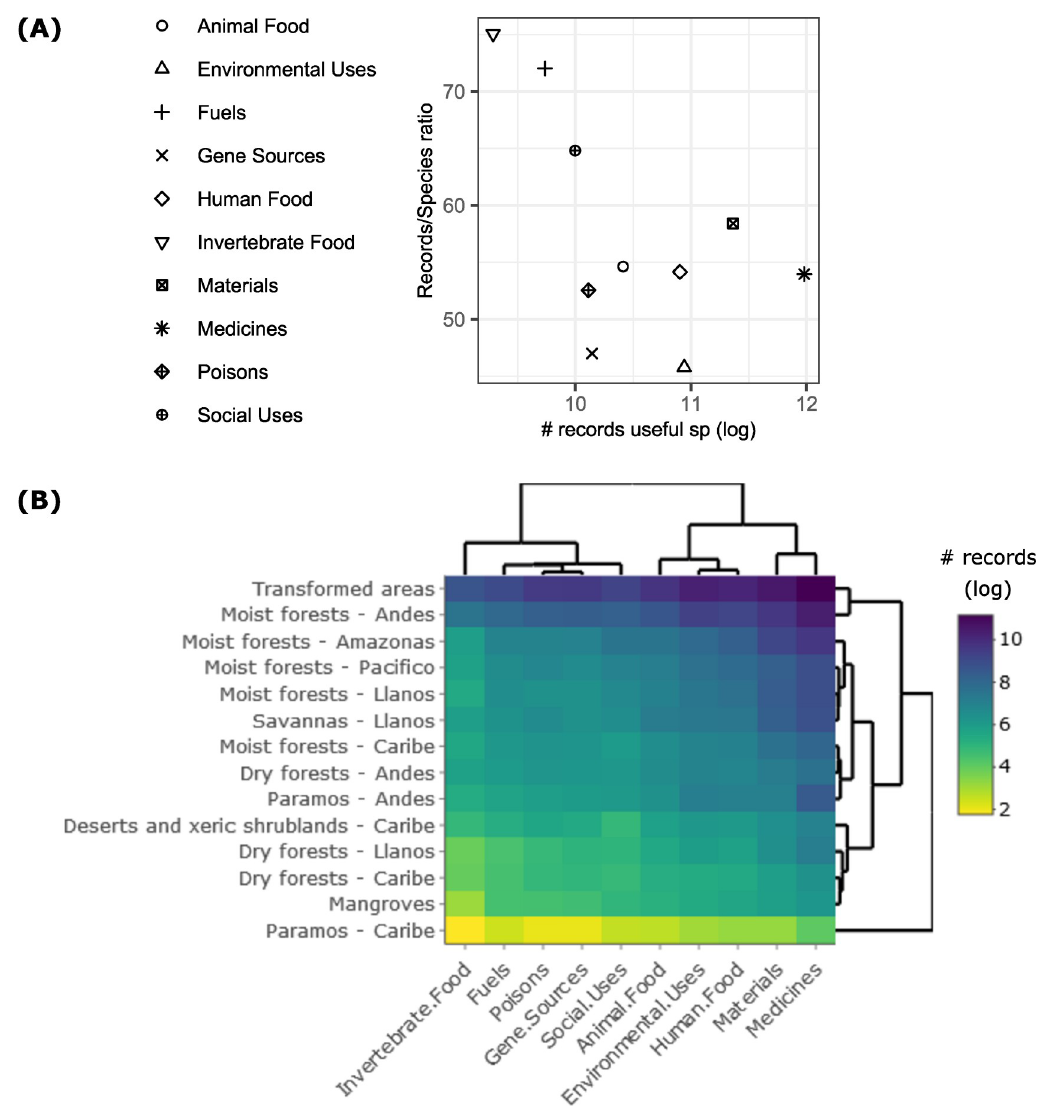
Fig 3. Records of useful plants per category of use. (A) Number of records of useful plants (log-transformed) vs the ratio of number of useful species per cell (species/cells ratio) for each category of use. (B) Number of records of useful plants (log- transformed) per category of use (axis x) and ecosystem (y axis). Dendrograms show clusters based on the number of